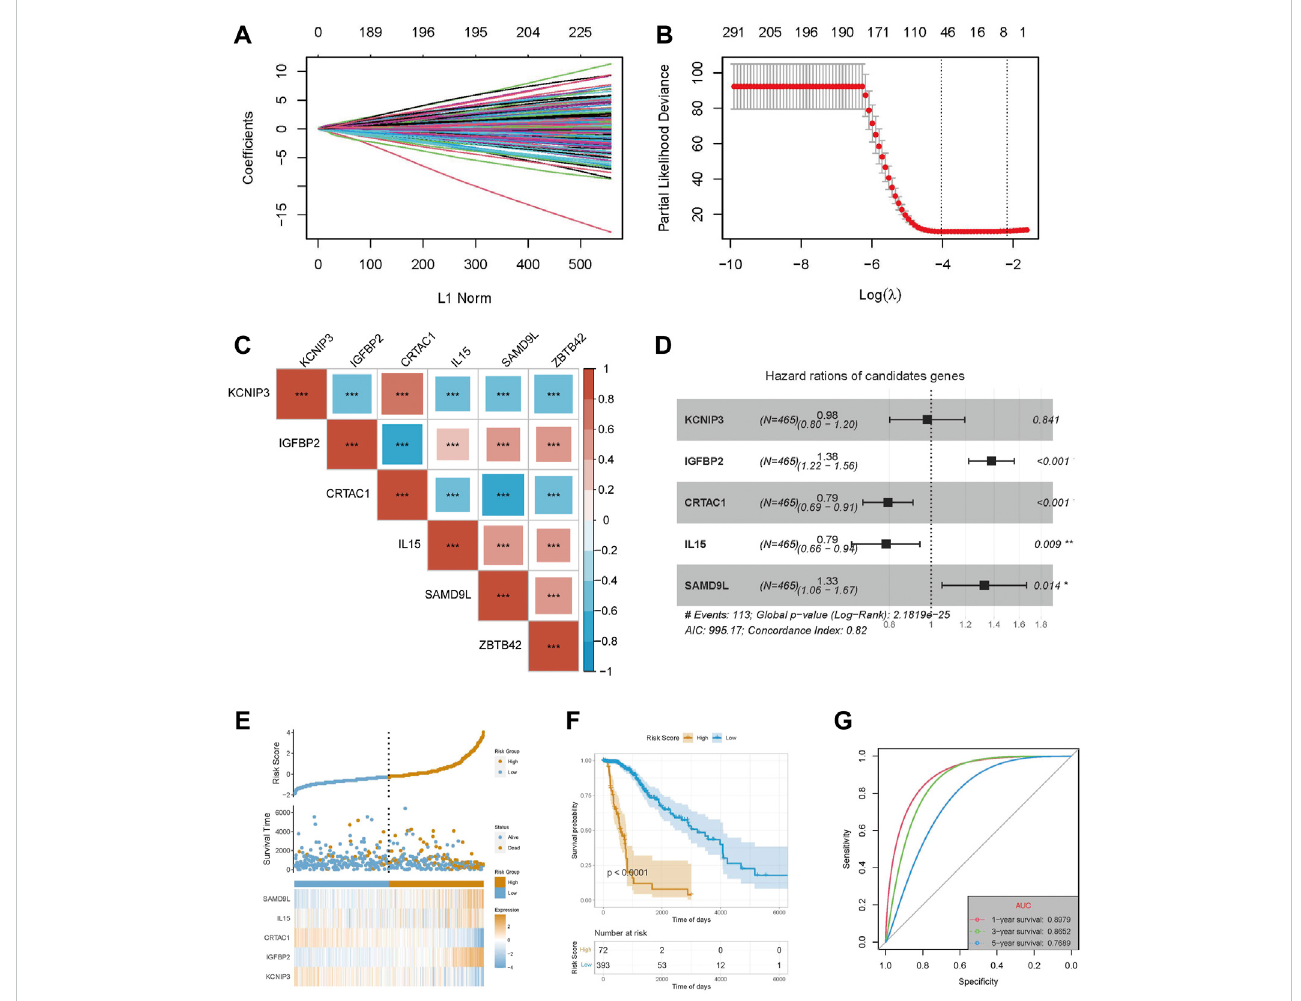
FIGURE 7 Construction of a prognostic model with ZBTB42-related genes in LGG. (A) LASSO coef fi cients pro fi les of DEG between high ZBTB42 expression group and low expression group in LGG. (B) LASSO regression with cross-validation obtained optimal prognostic-related genes in LGG. (C) Map of ZBTB42 correlationwithprognosticrelatedgenesinLGG. (D) MultivariateCoxanalysisofKCNIP3,IGFBP2,CRTAC1,IL15,andSAMD9L withclinicaloutcomes for LGG. (E) The risk score, survival time, and expression distribution of the fi ve genes in the LGG cohort. (F) Kaplan-Meier survival analysis of high-risk model and low-risk model. (G) Prediction sensitivity validation of the prognostic model by receiver operating characteristic (ROC) curve analysis in 1, 3, and 5 years for LGG patients. * p < 0.05; ** p < 0.01; *** p <